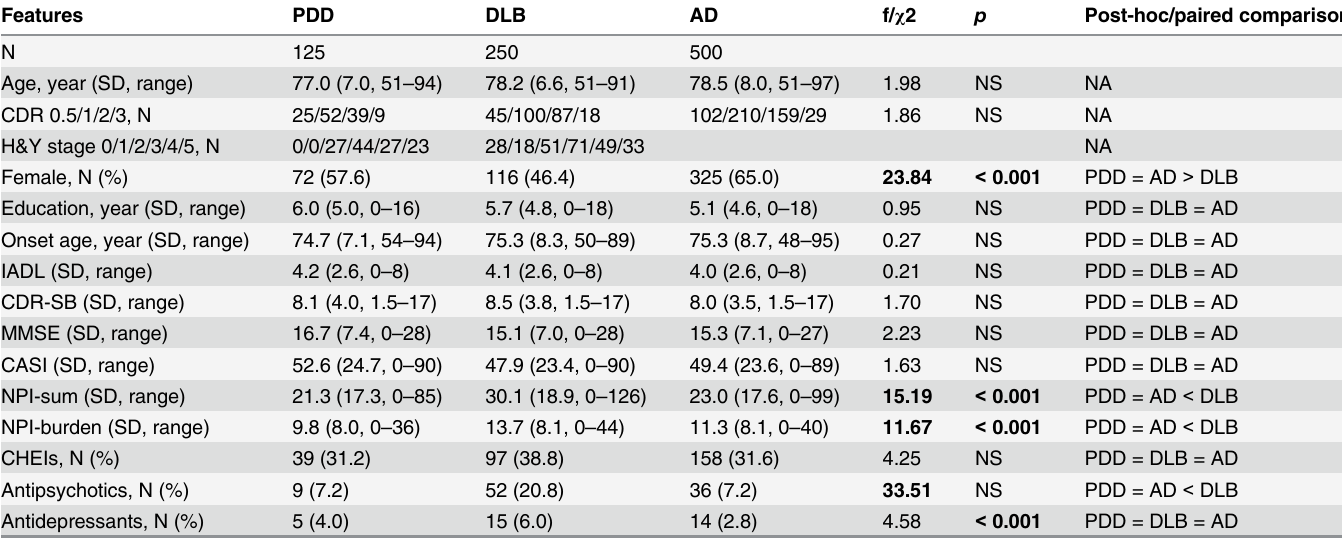
Table 1. Comparison of demographic data among the PDD, DLB and AD